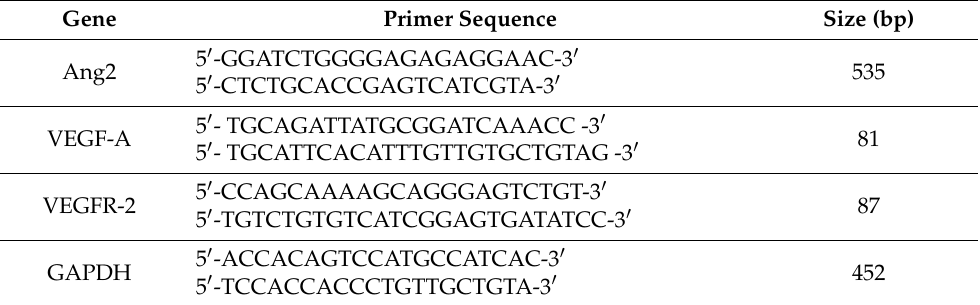
Table 1. Primer sequence used for